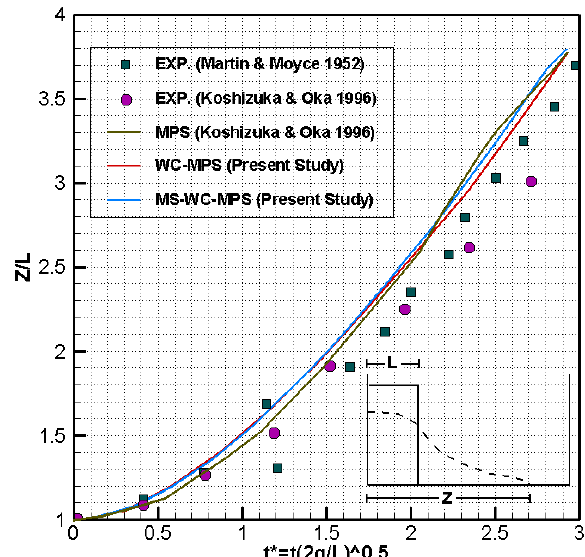
Figure 9. Comparison for the dam-break wave front position between the experimental, MPS, WC-MPS, and MR-WC-MPS